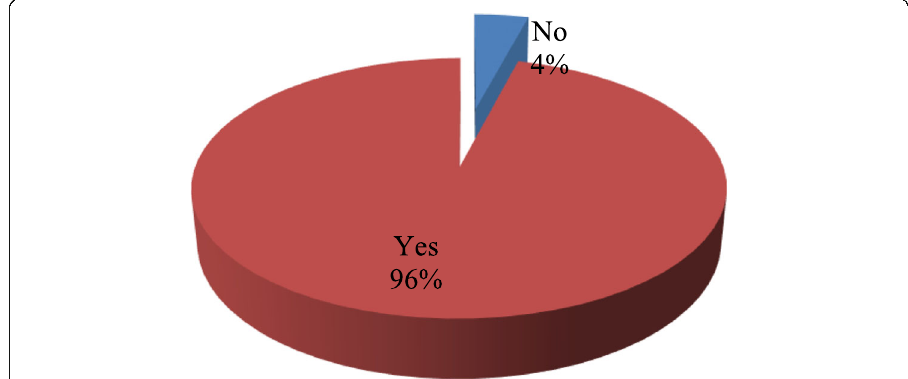
Fig. 5 Proportion of Respondents who needed finance but had No access. Source: Abraham and Fonta